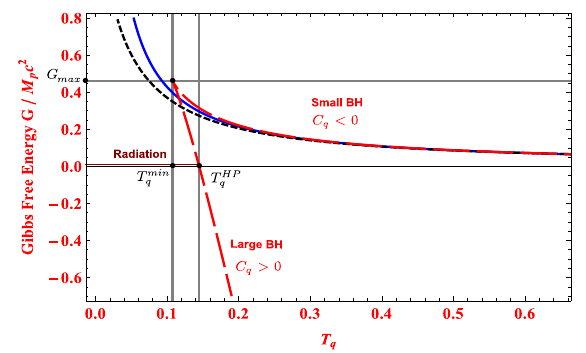
Fig. 4 The figure shows the free energy of a Schwarzschild BH in the Tsallis model as a function of the temperature in the standard with Boltzmann entropy ( q = 1, blue-continuous) and the Tsallis entropy ( q > 1 , red-dashed and q < 1,